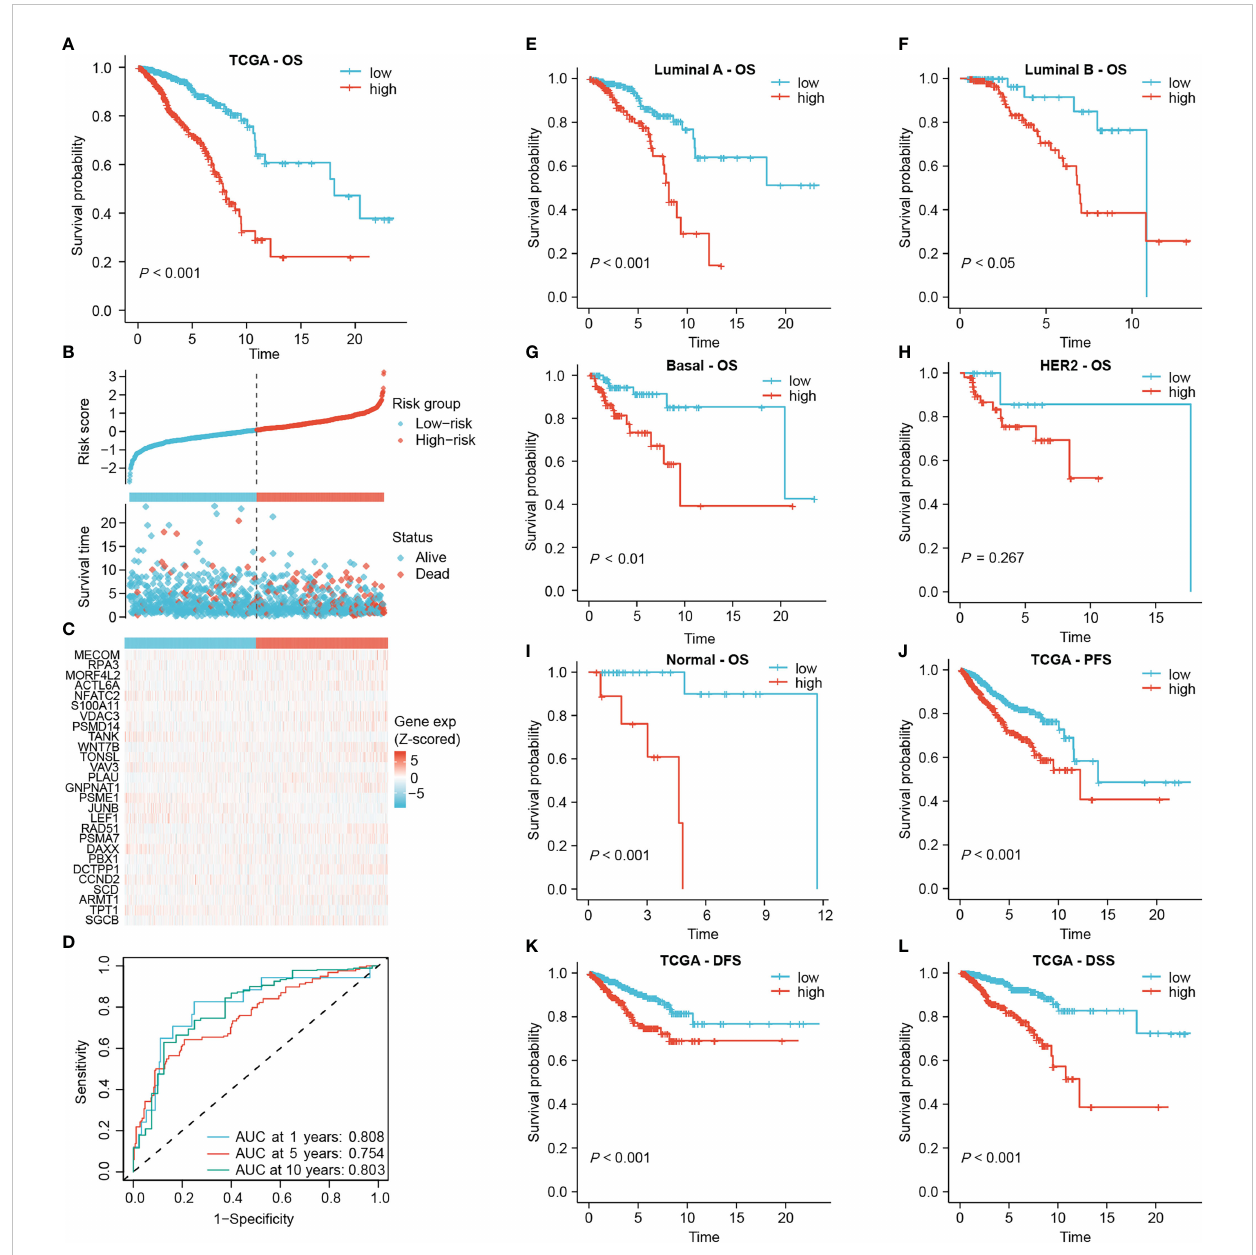
(D) ROC curves for signature evaluation. (E – I) Kaplan-Meier overall survival curves of patients with different PAM50 types. PFS curve (J) , DFS curve (K) and DSS curve (L) of all